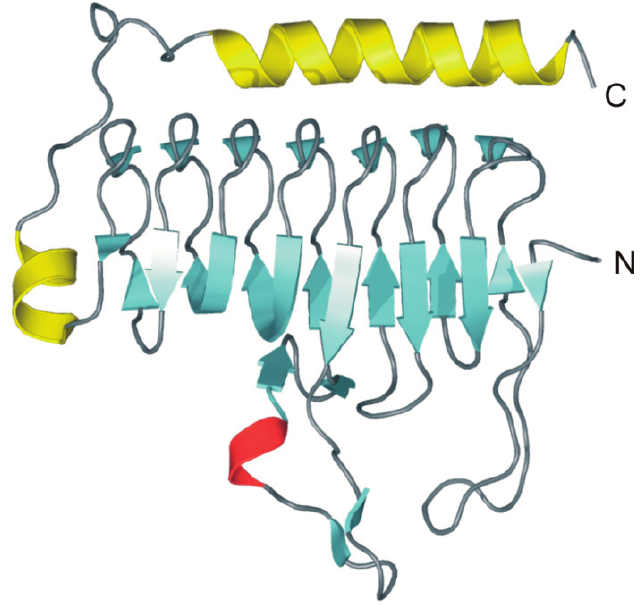
Figure 8. MtCam monomer overall fold (PDB code 1QRG). β -strands are shown in cyan, α -helices in yellow and the 3 10 -helix in red. Secondary structure assignments were obtained from PROMOTIF